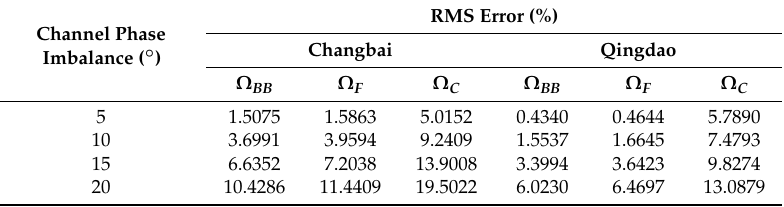
Table 4. RMS error ( σ RMS ) under the condition of channel phase imbalance.